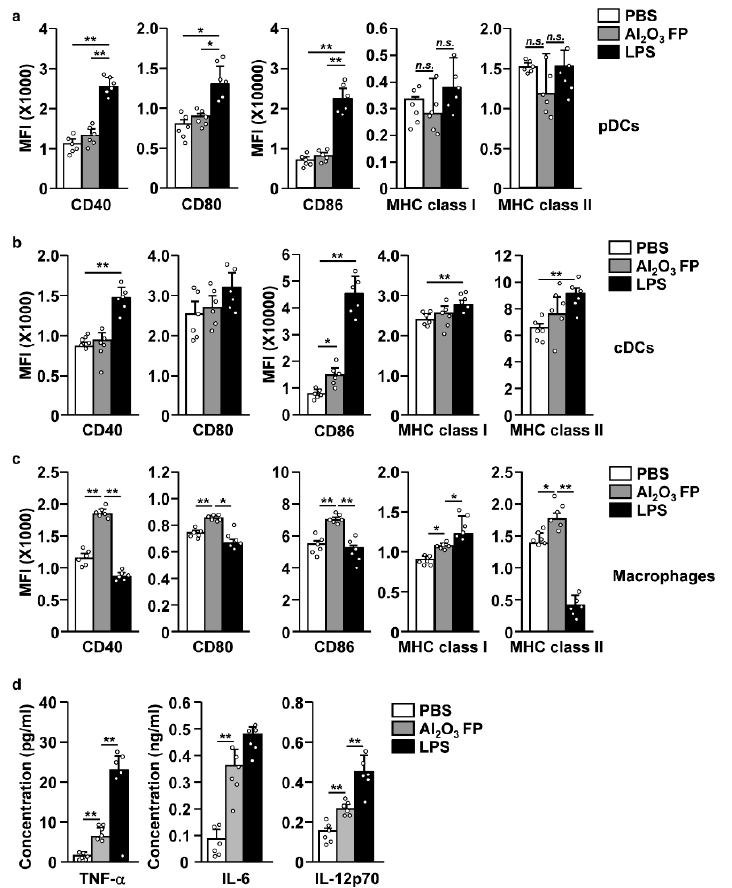
Figure 3. Al 2 O 3 FPs promoted the activation of macrophages, but not pDCs and cDCs. The C57BL/6 mice were i.p. injected with 10 mg/kg of Al 2 O 3 FPs. Spleens were harvested six hours post-injection, followed by flow cytometric analysis of the pDCs, cDCs and macrophages. The expression levels of co-stimulator and major histocompatibility complex (MHC) class I and II were shown in ( a ) pDCs, ( b ) cDCs and ( c ) macrophages ( n = 6 mice, two-way ANOVA, mean ± SEM). ( d ) Concentration of tumor necrosis factor-alpha (TNF- α ), interleukin (IL)-6, and IL-12p70 were measured by Enzyme Linked Immunosorbent Assay (ELISA). The data are averages of six independent samples (2 mice for three experiments, two-way ANOVA, mean ± SEM). * and ** represent p < 0.05 and p < 0.01, respectively.